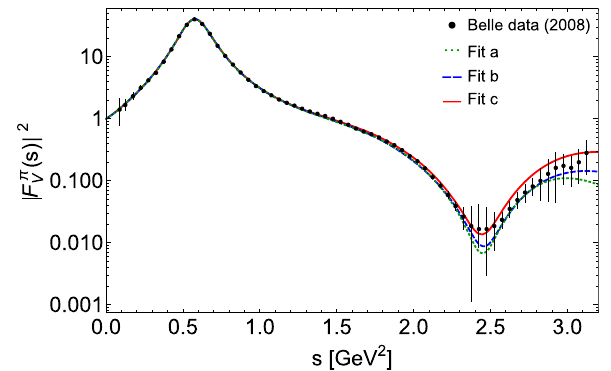
| 2 (black filled circles) [31] as com- Fig. 7 Belle measurement of | F π V pared to our fits obtained from a simultaneous analysis of | F π τ − → K − K ν τ (see Table 8) S